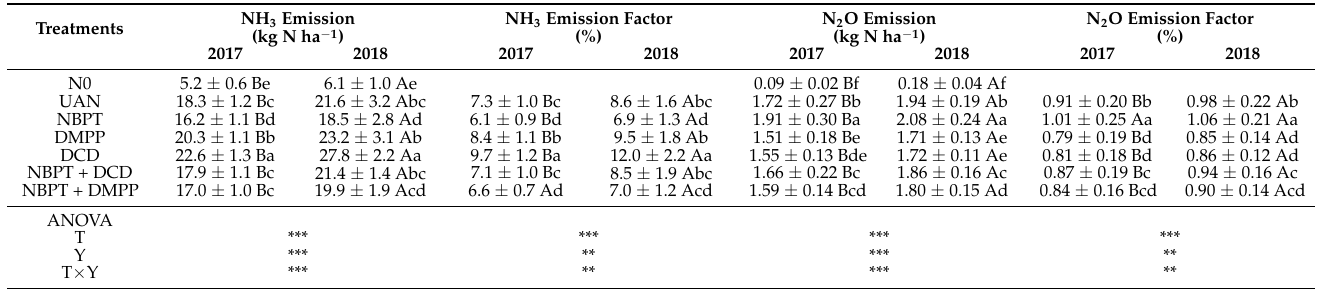
Table 1. Total NH 3 emission and N 2 O emission of different treatments in 2017 and 2018.